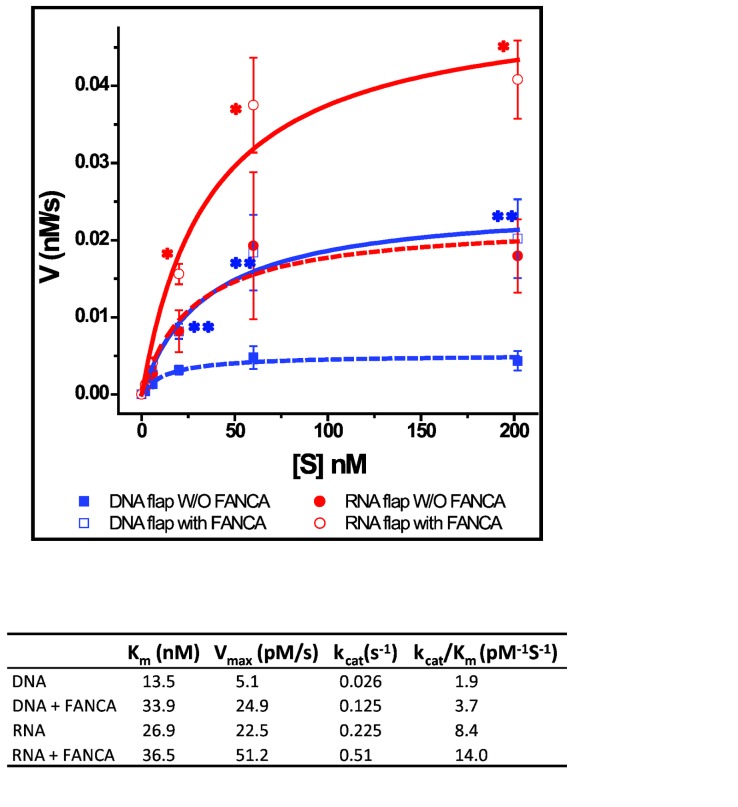
FANCA stimulates the 5’ flap endonuclease activity of FEN1 by enhancing enzyme efficiency.Steady-state analysis was perform by increasing the flap substrate concentration (0, 2, 6, 20, 60, 200 nM) and fixing amounts of FEN1 (0.2 nM for DNA flap, 0.1 nM for RNA flap) and/or FANCA (10 nM) in three independent FEN1 endonuclease assays. Vmax is determined as described in “Material and Methods”. Error bars represent stand errors. A paired t-test was performed to determine the statistical significance of FEN1 endonuclease activity between with and without FANCA. **, p<0.01; *, p<0.05.